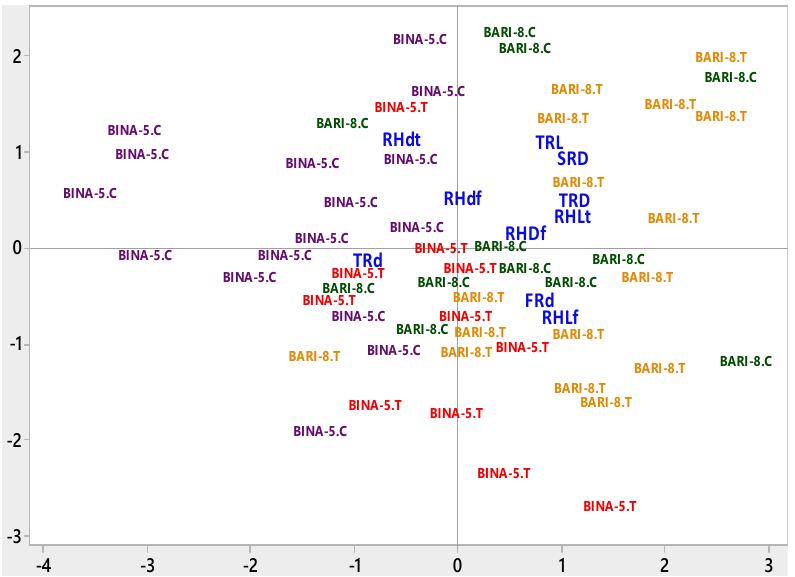
Figure 8. Biplot of root and root hair traits. BARI-8.C = BARI Sarisha-8 under Control, BARI-8.T = BARI Sarisha-8 under Treated condition, BINA-5.C = Binasarisha-5 Control, BINA-5.T = Binasarisha-5 under Treated condition, FRd = Diameter of first-order lateral roots, SRD = Density of second-order lateral roots, TRL = Length of third-order lateral roots, TRd = Diameter of third-order lateral roots, TRD = Density of third-order lateral roots, RHLf = Length of root hairs on first-order lateral roots, RHdf = Diameter of root hairs on first-order lateral roots, RHDf = Density of root hairs on first-order lateral roots, RHLt = Length of root hairs on third-order lateral roots, and RHdt = Diameter of root hairs on third-order lateral roots.